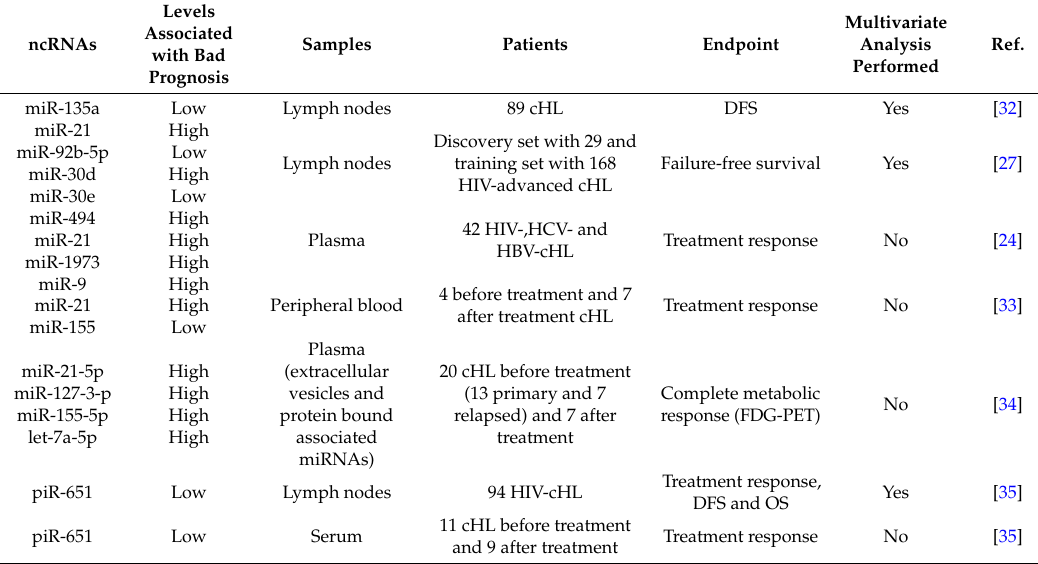
Table 2. Non-coding RNAs associated with clinical outcome in